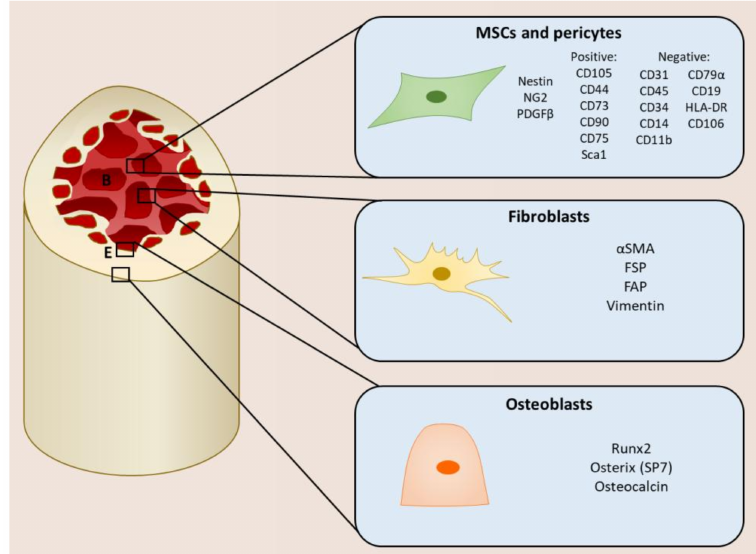
Figure 1. Mesenchymal stromal cells within the bone. MSCs, pericytes and fibroblasts are found at the perivascular niche along the blood vessels (B), whereas osteoblasts are located at the endosteal niche (E). (NG2 neural glial antigen 2; PDGF β platelet derived growth factor beta; α SMA alpha smooth muscle actin; FSP fibroblast specific protein; FAP fibroblast activation protein)